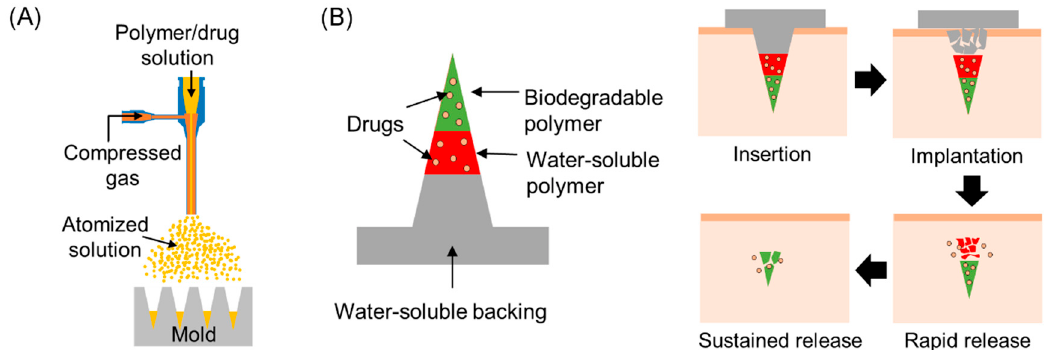
Figure 1. ( A ) Schematic diagram of spray deposition setup for polymer microneedle fabrication. ( B ) The concept of layered microneedles for biphasic drug delivery. Once inserted, the microneedle would be embedded in the skin due to dissolution of water-soluble polymers, and rapidly release drugs incorporated in a water-soluble matrix. Biodegradable tips would remain in the skin, releasing drugs for an extended period of time.